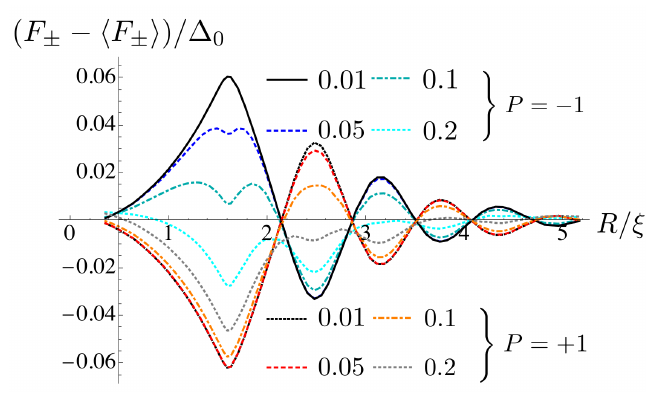
Figure 3: The free energy F ± (Eq. (8)) normalized by the full gap ∆ parity sectors P = ± 1 as a function of the inter-vortex separation R /ξ for a range of temperatures, with labels referring to the values of k energy averaged over R /ξ .